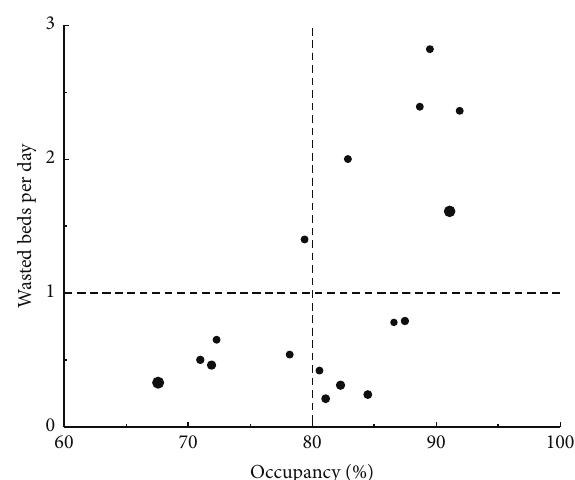
Figure 3: Intensive care unit occupancy versus wasted ICU beds per day. Average of the monthly occupancy is plotted against the average number of wasted ICU beds per day. Bubble size is proportional of patient flow (patients/bed/year). Vertical dashed line is at 80% occupancy and horizontal dashed line at 1 wasted bed per